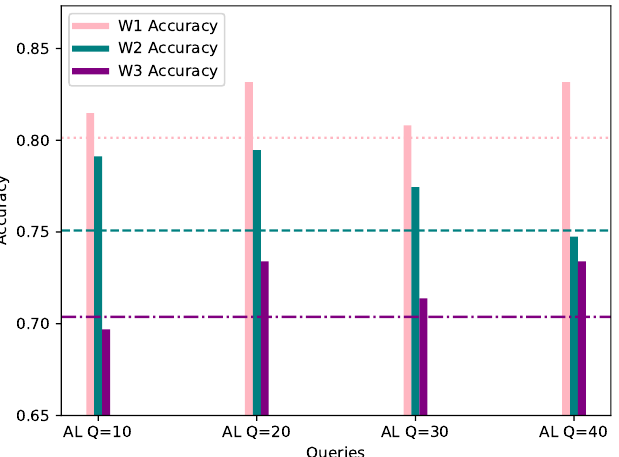
Figure 10. Accuracy of W1, W2 and W3’s models personalized with balanced AL dataset ( Y -axis) per Query ( X -axis), evaluated using their corresponding evaluation datasets. The FL accuracy for each worker is represented by the horizontal line of the worker’s respective color.